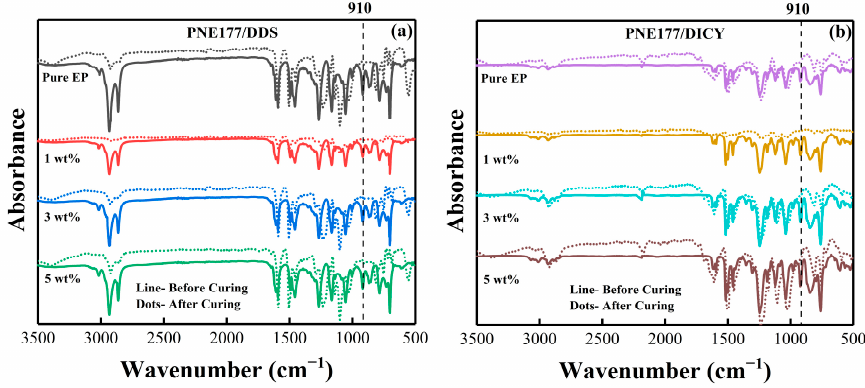
Figure 10. FTIR spectra of PNE-177/DDS ( a ) and PNE-177/DICY ( b ) system epoxy